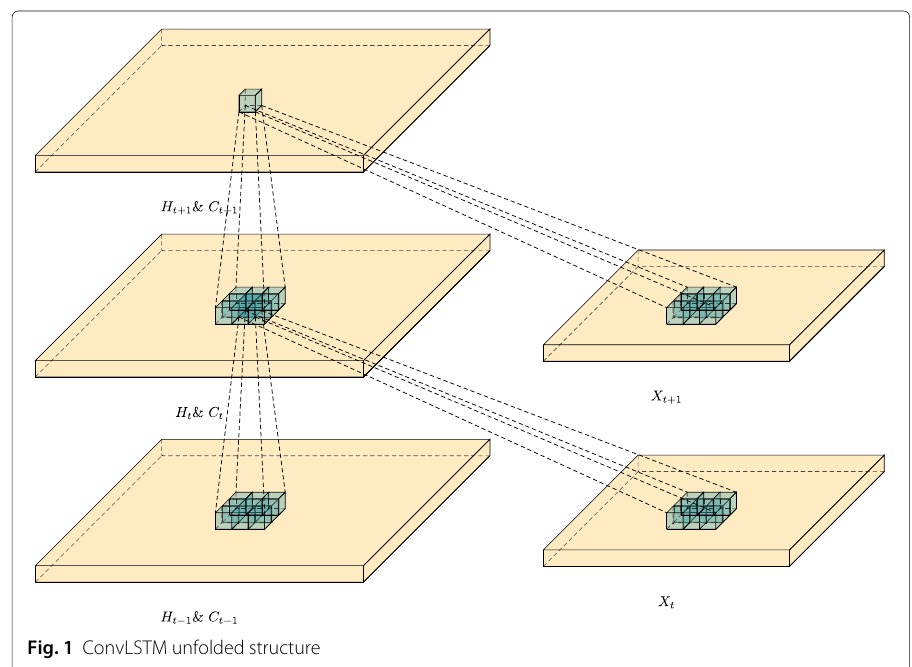
Fig. 1 ConvLSTM unfolded